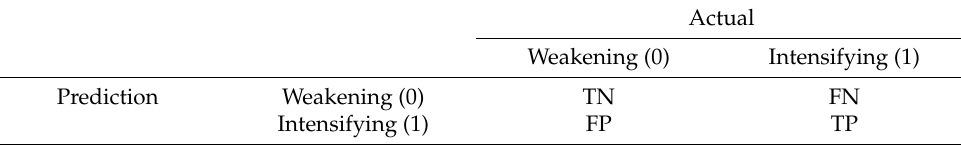
Table 2. The confusion matrix reports the number of false positives (FP) model indicates an inten- sifying storm, when in the real world it was weakening, false negatives (FN)—model indicates a weakening storm, when in the real world it was intensifying, true positives (TP)—model correctly in- dicates an intensifying storm, and true negatives (TN)—model correctly indicates a weakening storm.